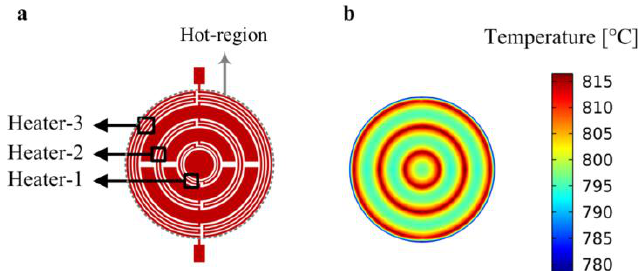
Figure 5. Micro-heater ( a ) and FEM results for the surface temperature distribution (°C) within the hot-region ( b